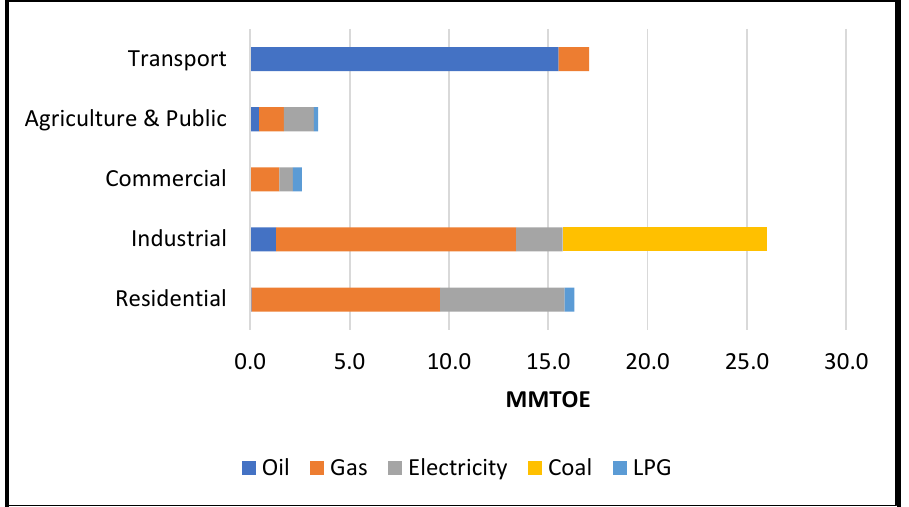
Figure.1. Final Energy Demand by Type and Sector (2019) Source: Author’s own